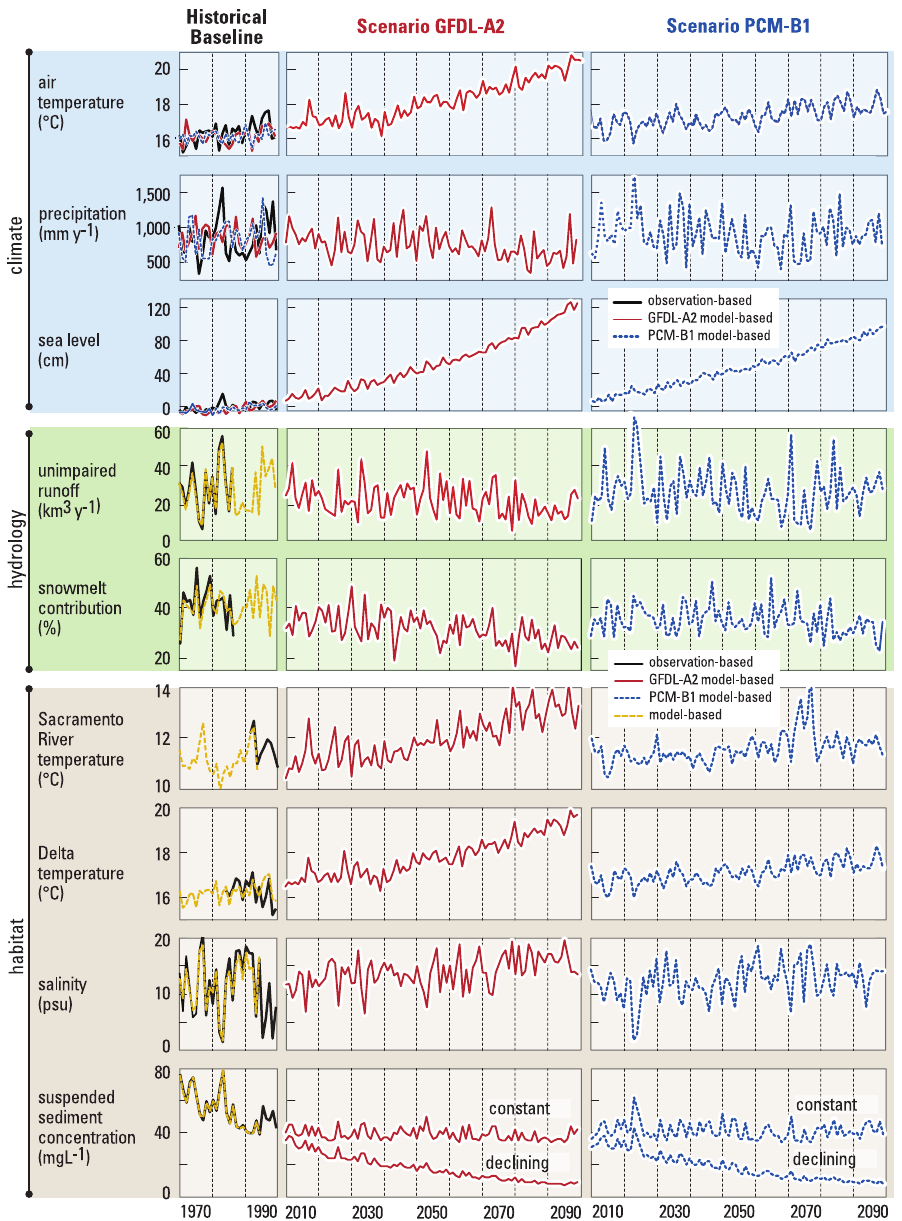
Figure 2. Projected 2010–2099 changes in annual mean values of nine environmental indicators for the A2 (red lines) and B1 (blue lines) scenarios compared to modeled and observed values during the 1970–1999 baseline period (left panels). The indicators measure changes in regional climate, regional hydrology, and habitat quality in the San Francisco Estuary-Watershed system. The GFDL-A2 and PCM- B1 ‘‘historical’’ data represent simulated realizations of possible climates constrained only by historical GHG forcing, and thus are not expected to track observed historical variability on a year-to-year basis.